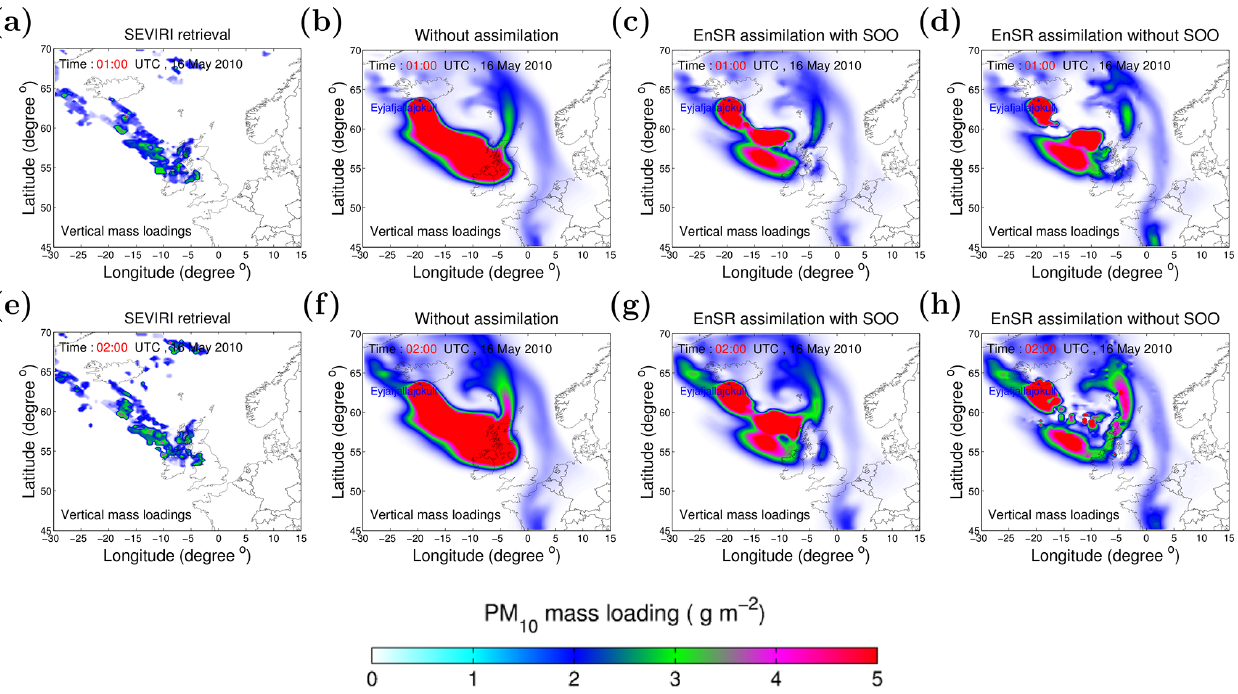
Figure 7. Evaluation of the assimilation effects by EnSR with SOO and without SOO at 01:00/02:00UTC 16 May